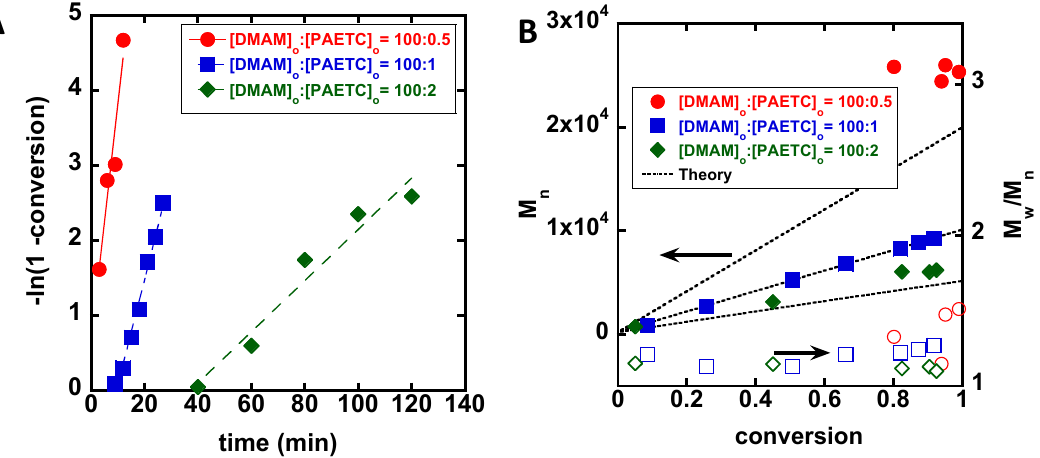
Figure 2. ( A ) Semilogarithmic plots and ( B ) evolution of M n (solid points) and M w /M n (open points) of HRP-catalyzed polymerization. Red points (circles) show [DMAM] 0 :[PAETC] 0 = 100:0.5. Blue points (squares) show [DMAM] 0 :[PAETC] 0 = 100:1. Green points (diamonds) show [DMAM] 0 :[PAETC] 0 = 100:2. Assays were conducted with component ratios of [DMAm] 0 :[PAETC] 0 :[ACAC] 0 :[H 2 O 2 ] 0 = 100: X :9.7:1.7, and concentrations of [DMAm] = 170 mM, [HRP] = 0.71 mg/mL in 4.2 mL of pH = 5.5, 20 mM acetate buffer at 25 °C.